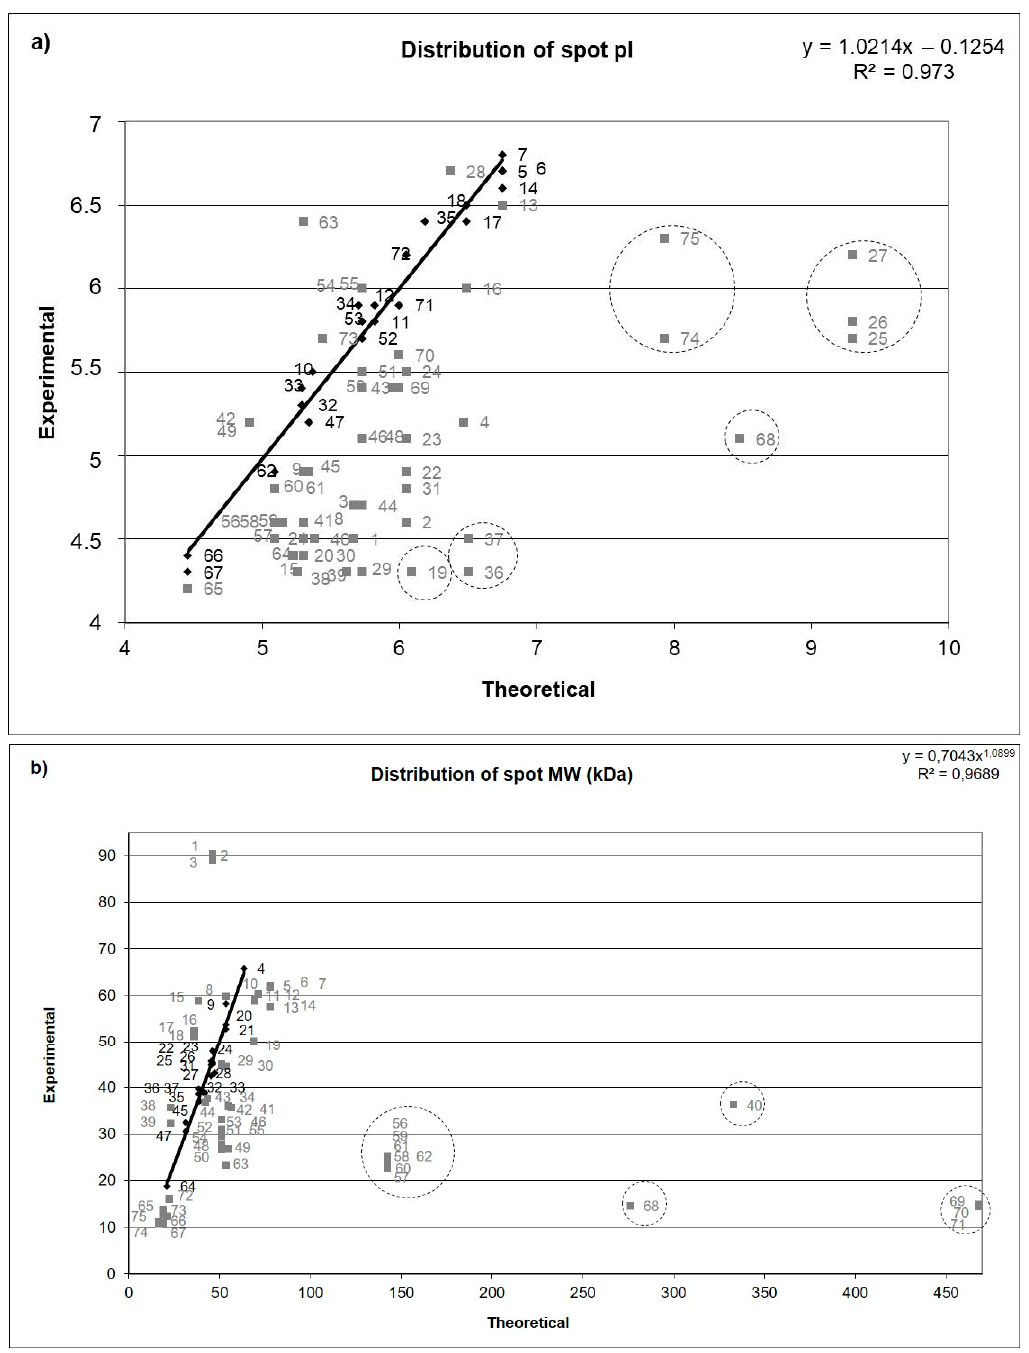
Figure 2. The graphs illustrate differences between proteins’ spot position on the gel and the theoretically calculated protein pI ( a ) and molecular weight ( b ). Spots used for the curve preparation and other plotted spots are marked with black rhombs and grey squares, respectively. Spots found as outliers are circled with dashed line. Theoretically and calculated protein of pI and molecular weight, differences between calculated and theoretical MW and pI, potential modifications are presented in Table S1.